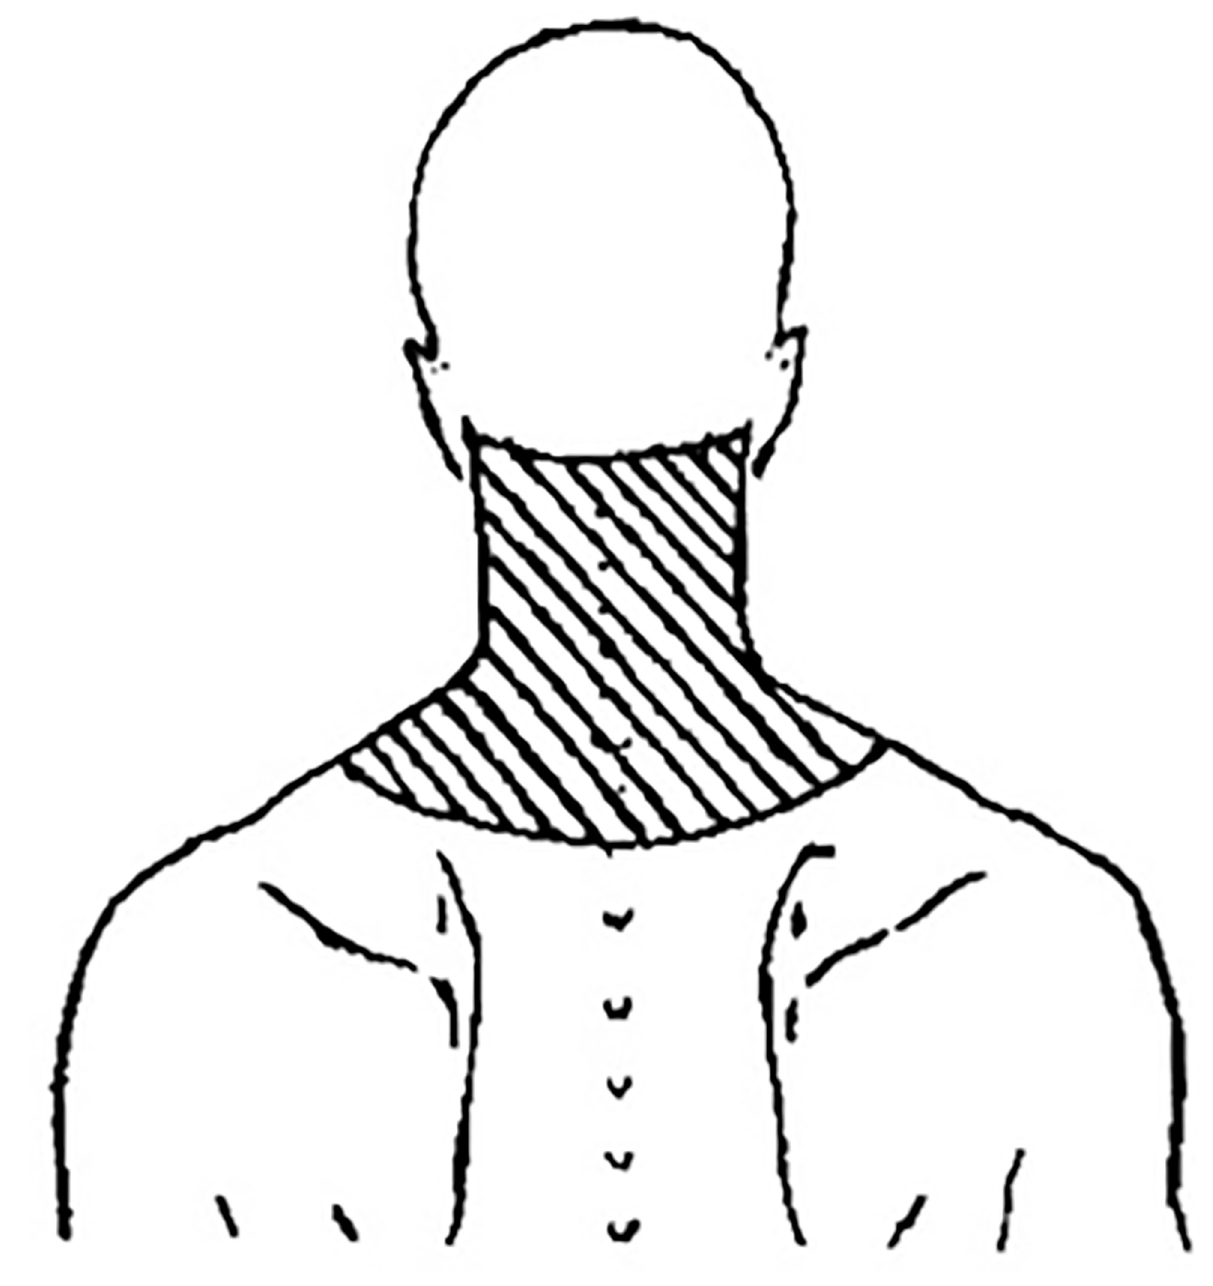
Fig 1. Neck pain area used for inclusion